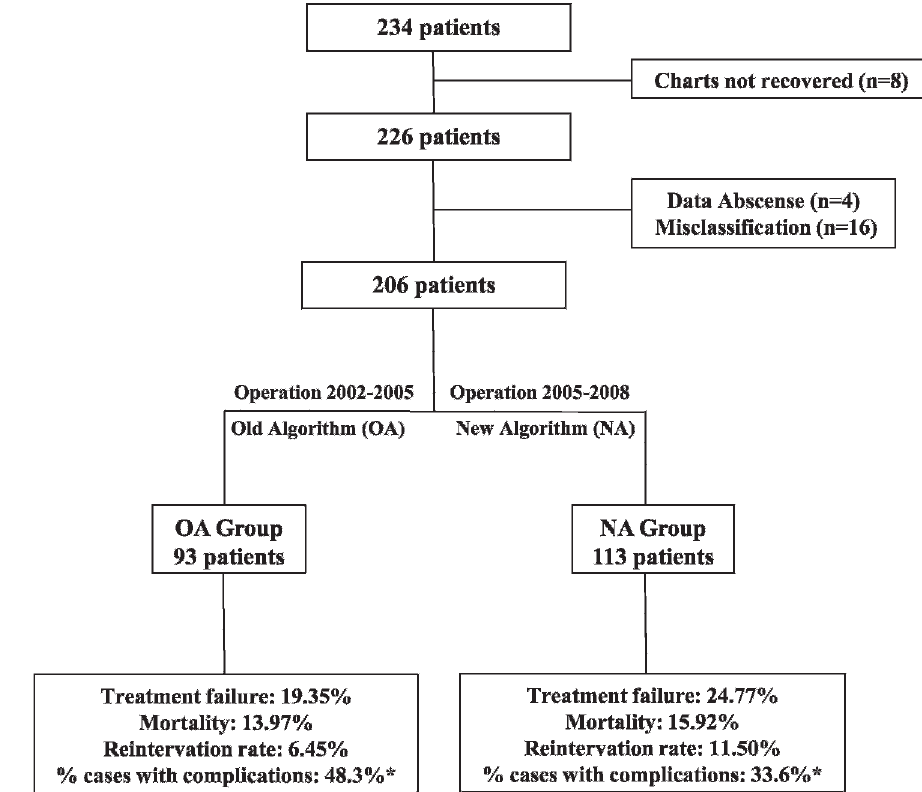
Figure 1 - Patient flow and the main results obtained. *, only the percentage of cases with at least one complication was statistically significant ( p=